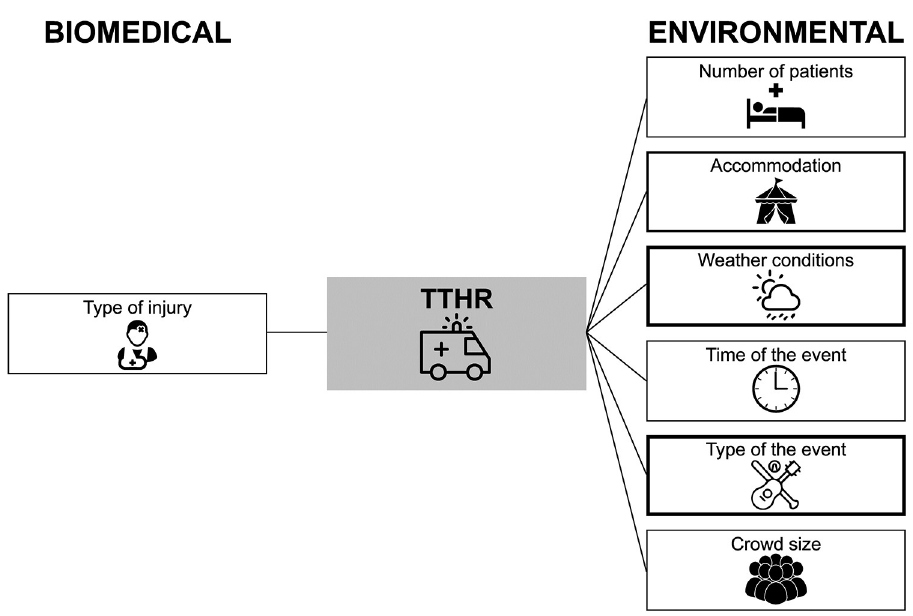
Fig 3. Biomedical and environmental variables from multivariable regression analyses predicting The Transfer to Hospital Rate (TTHR). The thickness of the box represents the number of multivariable models including the following predictors: type of injury (n = 1, intoxication vs medical vs trauma); number of patients (n = 1); accommodation (n = 2, mobile vs seated, bounded vs unbounded); weather conditions (n = 4, humidity, temperature, precipitation); time of the event (n = 1, day vs night); type of the event (n = 4, music genres, sport events); crowd size (n = 1).